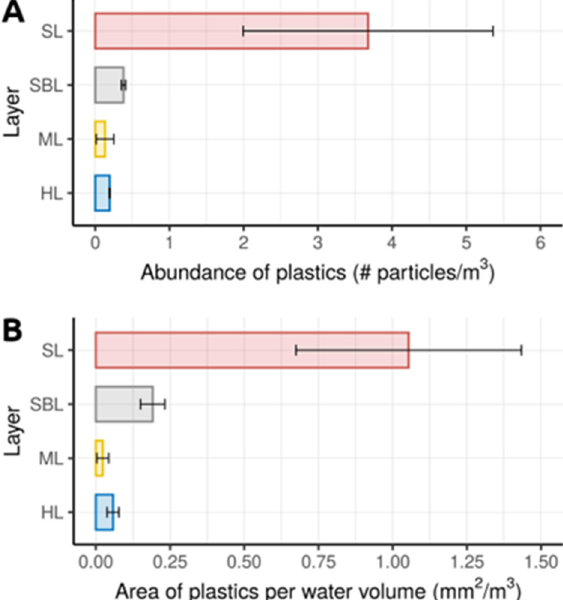
Figure 2. Presence of plastics in the water column expressed as ( A ) abundance of particles and ( B ) observed area of particles in the water volume. Error bars represent the mean standard error of sampling events.